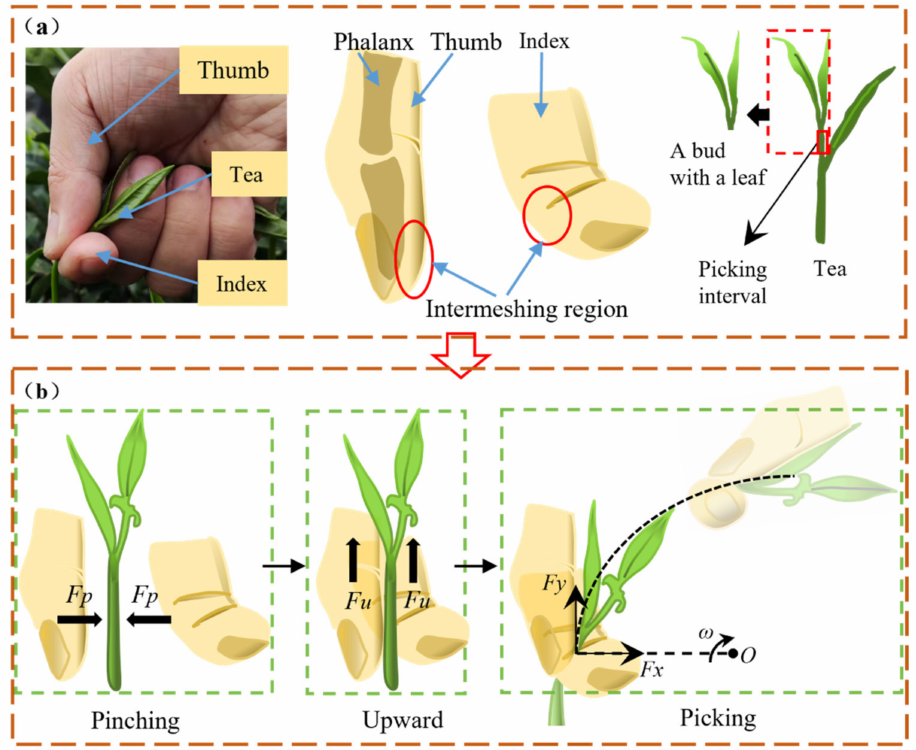
Figure 1. Analysis of tea-bud manual picking. ( a ) Hand-picked objects. ( b ) Manual picking process. Fp —Clamping force, Fu —Tensile force, Fy —y-axis component force, Fx —x-axis component force, ω —Tensile force, O —Tensile force.